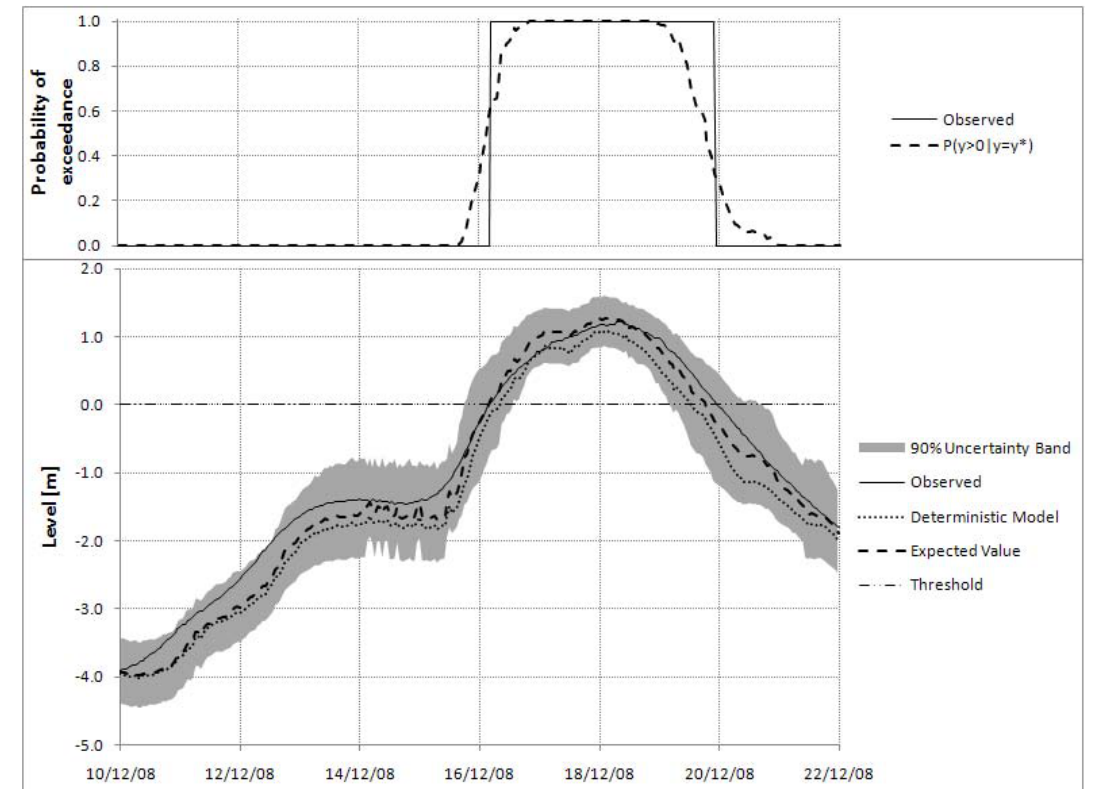
Fig. 9. Flood event for the validation period predicted 36h in advance. The lower panel represents the level forecast; observed values (continuous line); deterministic forecast (dotted line); expected value conditioned to the model forecast (dashed line); 90% uncertainty band (grey area); and alarm threshold of 0m (horizontal dashed line). The upper panel represents the probability of exceeding the alarm threshold; observed binary response (continuous line) and probability of exceeding the threshold computed by the MCP (dashed line).